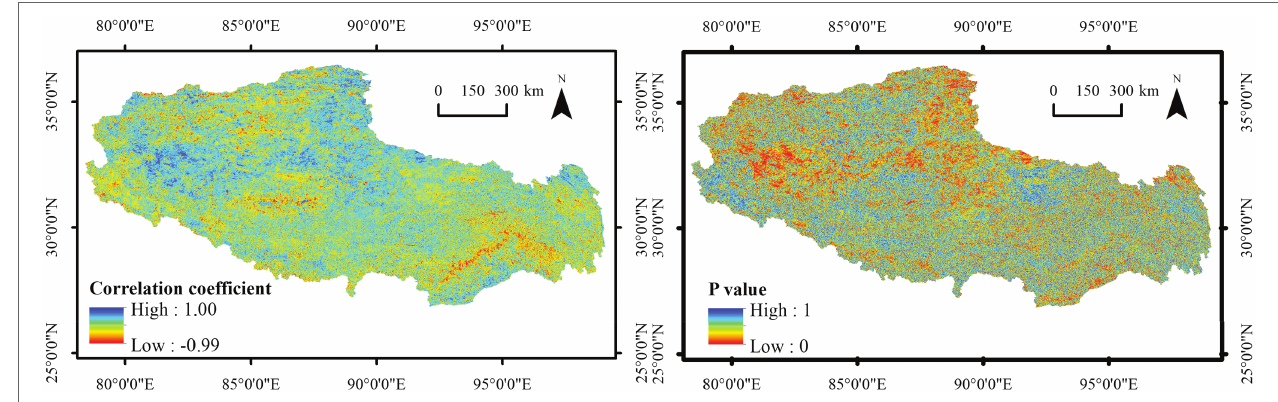
FIGURE 10 | Spatial distribution of correlation coefficients and significance between NDVI and nighttime light data in Tibet from 2013 to